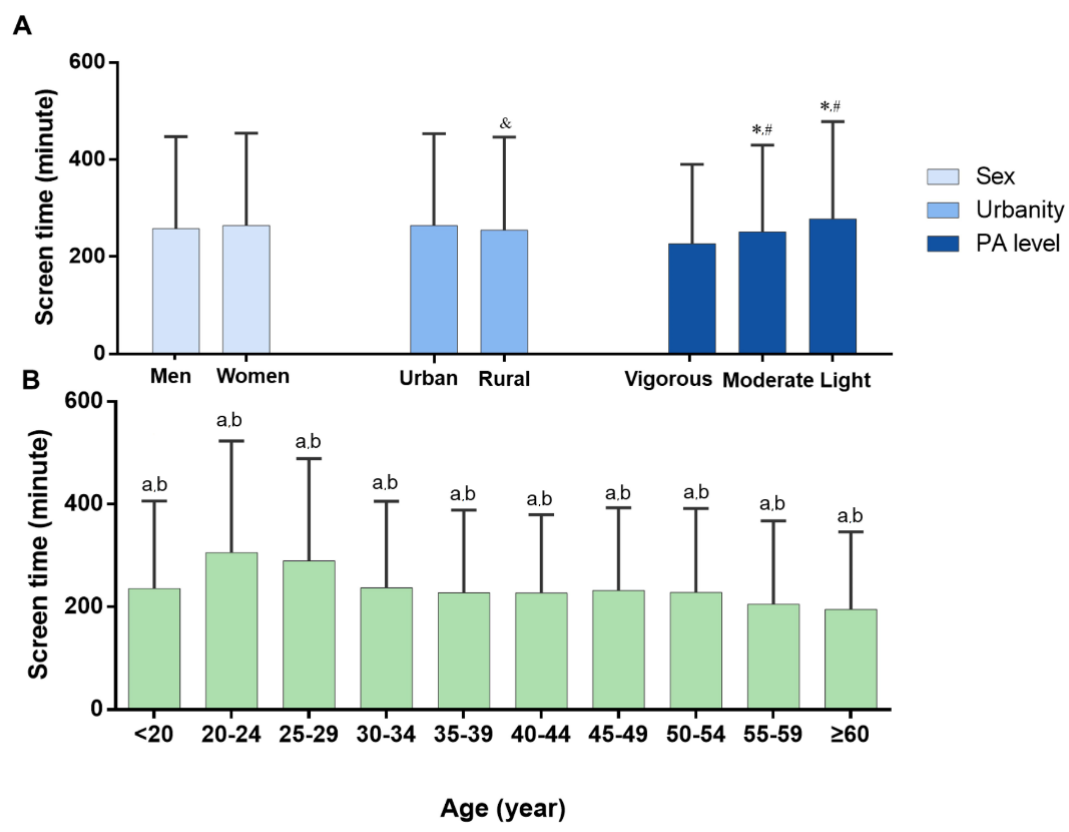
Figure 3. Screen time among Chinese residents aged 18 years and over during home quarantine induced by COVID-19, 2020. ( A ): Comparisons in screen time by sex, urban or rural residence, and physical activity level. ( B ): Comparisons in screen time by age. PA = physical activity. & p < 0.05 versus Urban; * p < 0.05 versus Vigorous level; # p < 0.05 versus Moderate level; a p < 0.05 versus 20–24; b p < 0.05 versus 25–29. All values were presented as mean ± SD.